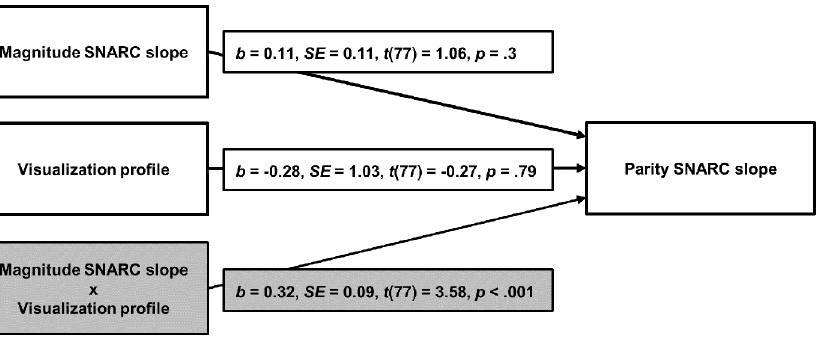
Figure 2. Simple moderation analysis results for visualization profile with unstandardized regression